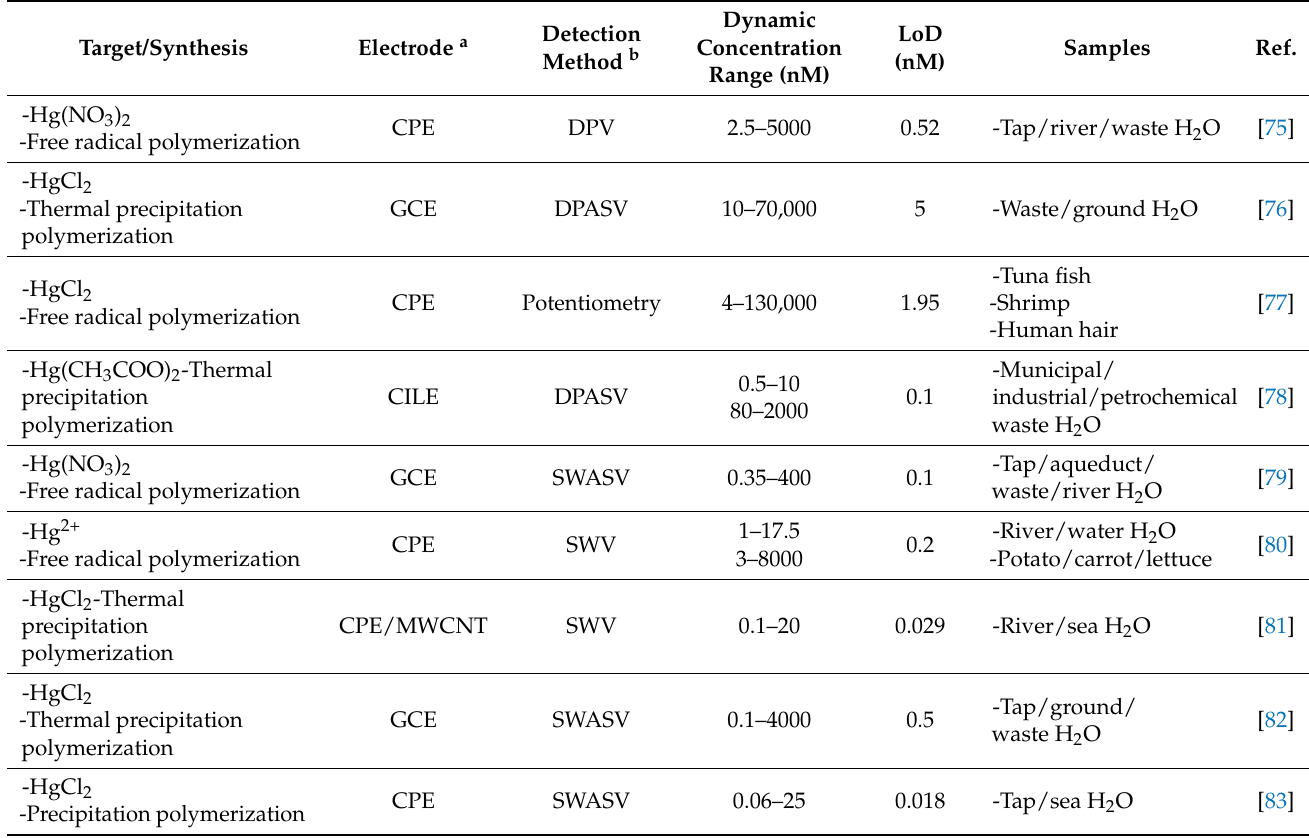
Table 3. Summary of studies which have utilized IIPs for the electrochemical detection of